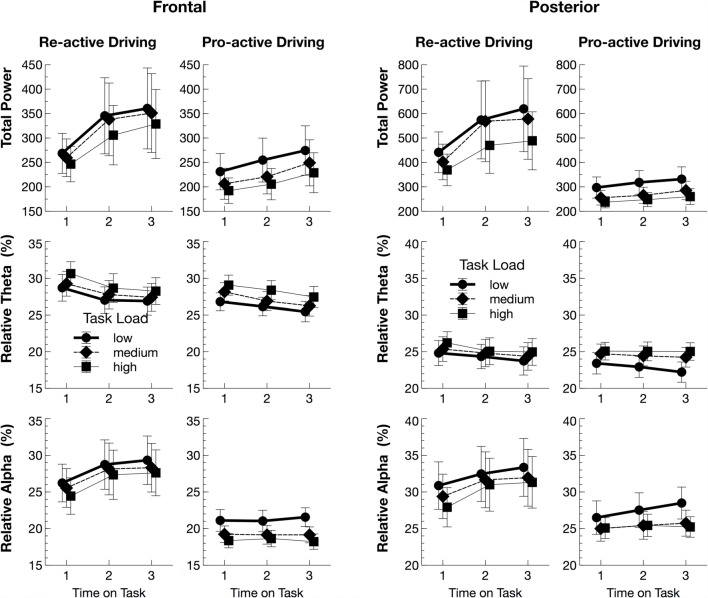
Mean values (with standard errors of mean) for total power and relative power in the Alpha and Theta band for frontal and posterior electrodes.